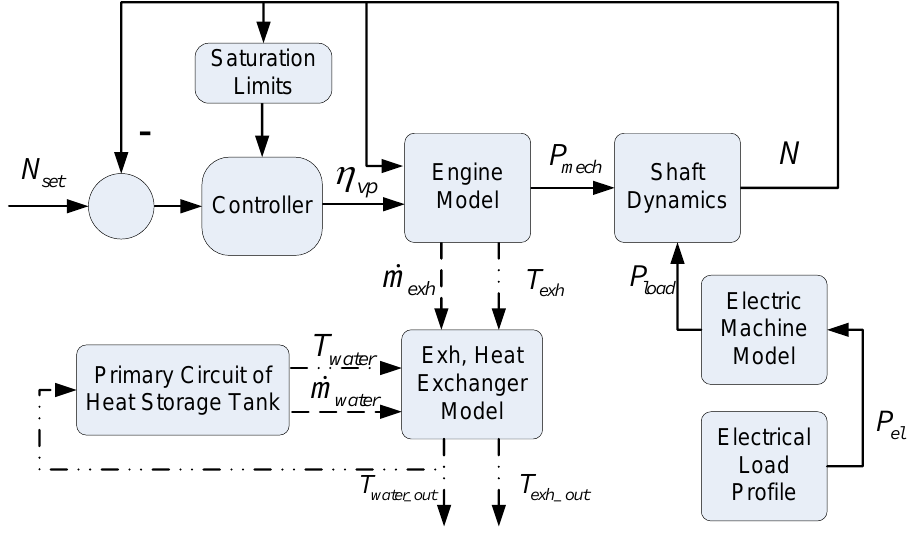
Figure 5. Block diagram of the use of the engine model with a simple exhaust heat recovery system.